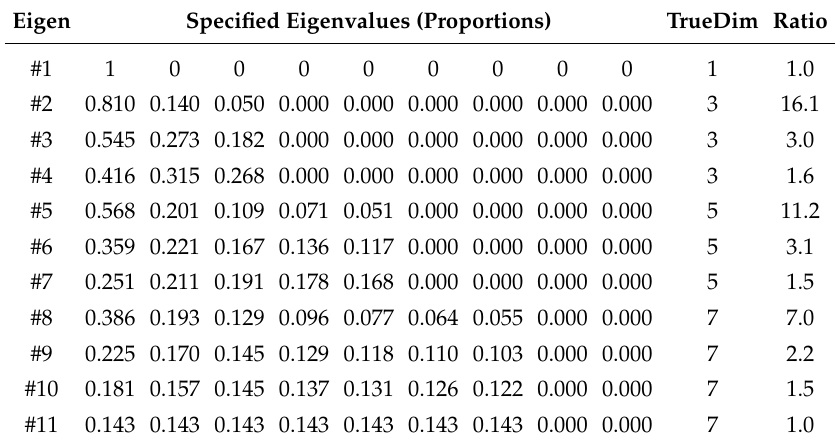
Table 1. Relative proportions of eigenvalues of the 11 simulated data structures used for testing the stopping rules prior the introduction of noise. In the last columns, the true dimension of the data and the ratio between the first and the last non-zero eigenvalues are shown. The eigenvalues of the noise-free data structures correspond to these proportions multiplied by